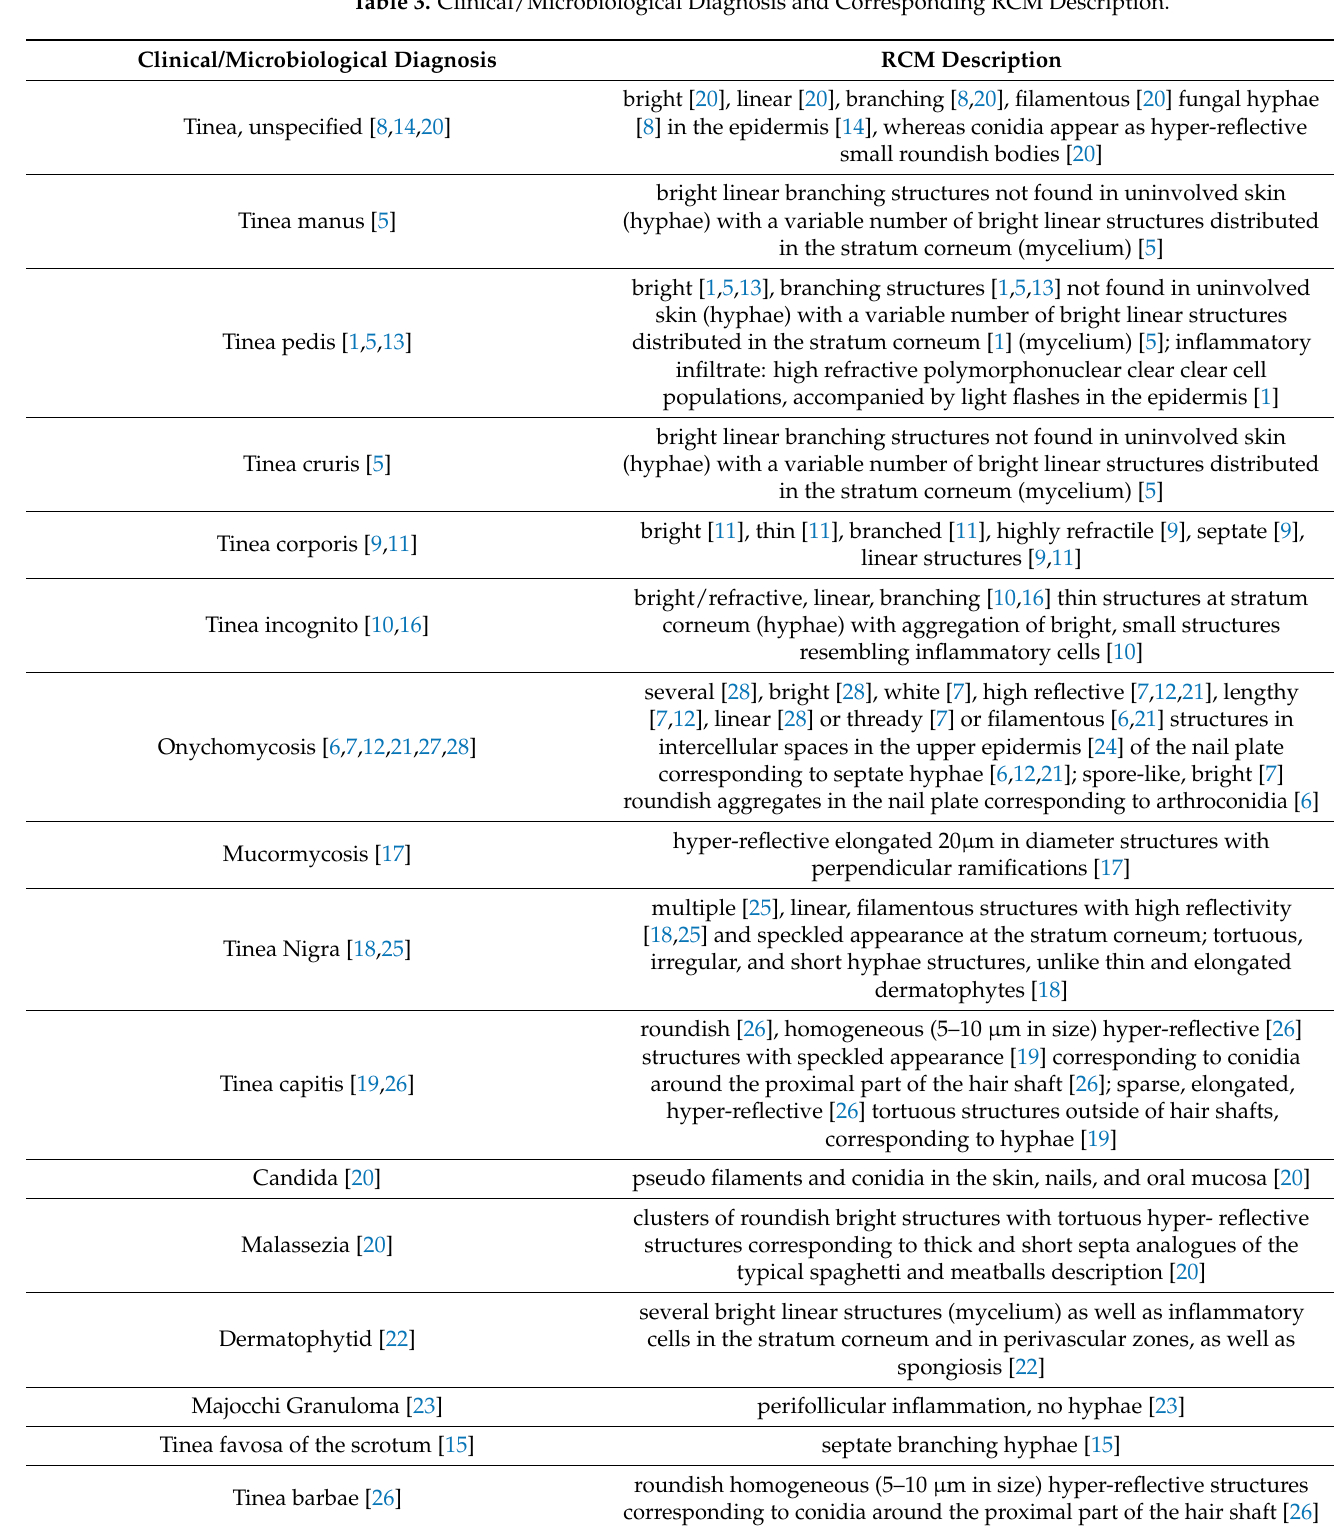
Table 3. Clinical/Microbiological Diagnosis and Corresponding RCM